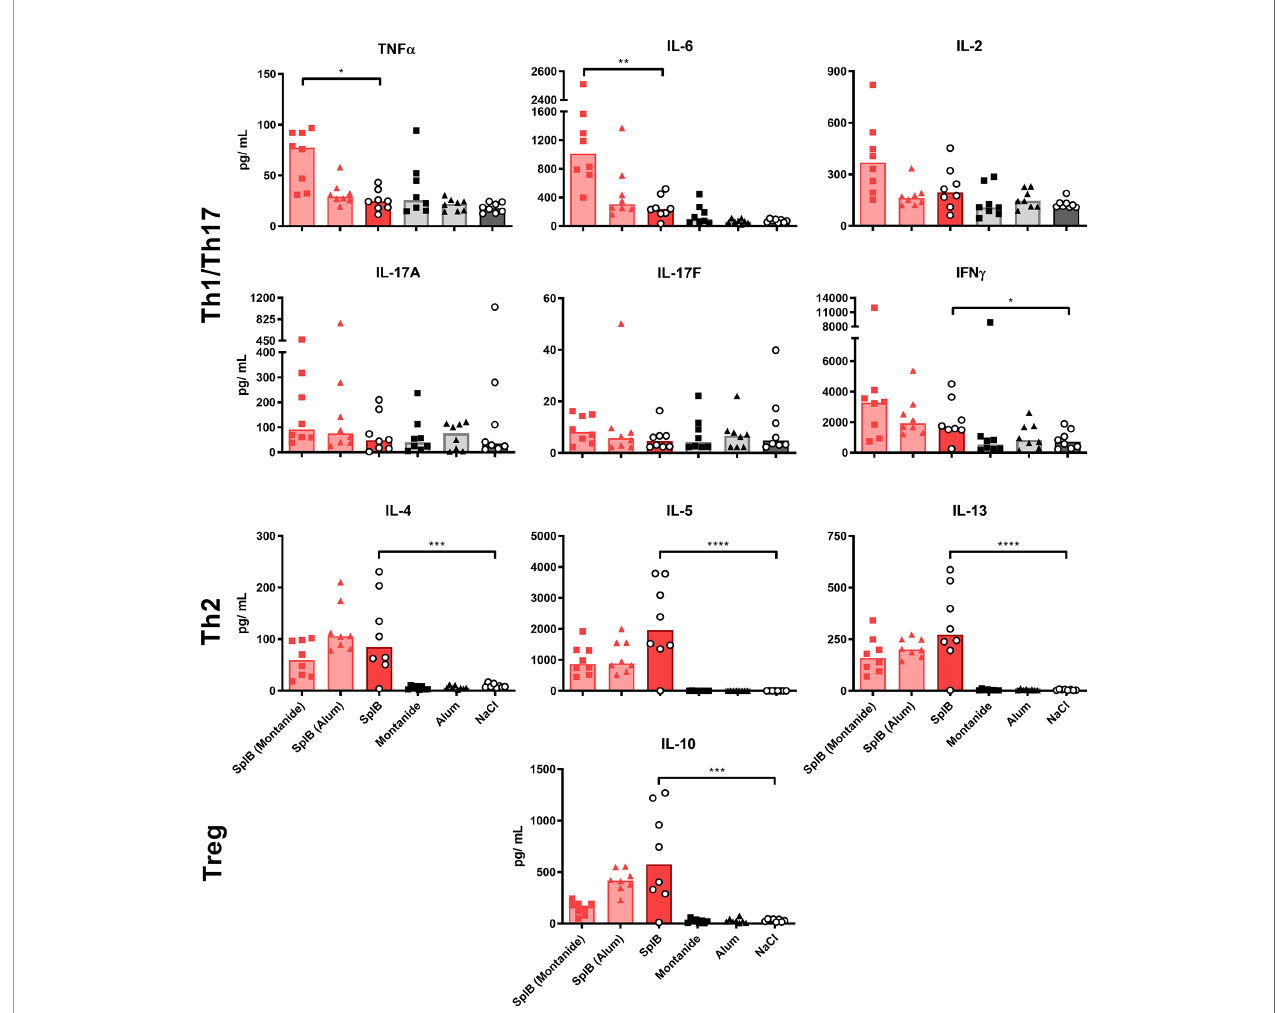
FIGURE 3 | Adjuvants had little effect on cytokine production of SplB-treated animals. Isolated splenocytes were restimulated with SplB for 4 days, afterward the supernatant was harvested and the concentration of produced cytokines was measured via the LEGENDplex ™ Mouse Th Cytokine Panel (13-plex). Data are presented as median. n = 8 animals per group. *p < 0.05; **p < 0.01; ***p < 0.001; ****p < 0.0001. Group comparisons that are de fi ned in the “ Statistical analysis ” section but not shown here are not signi fi